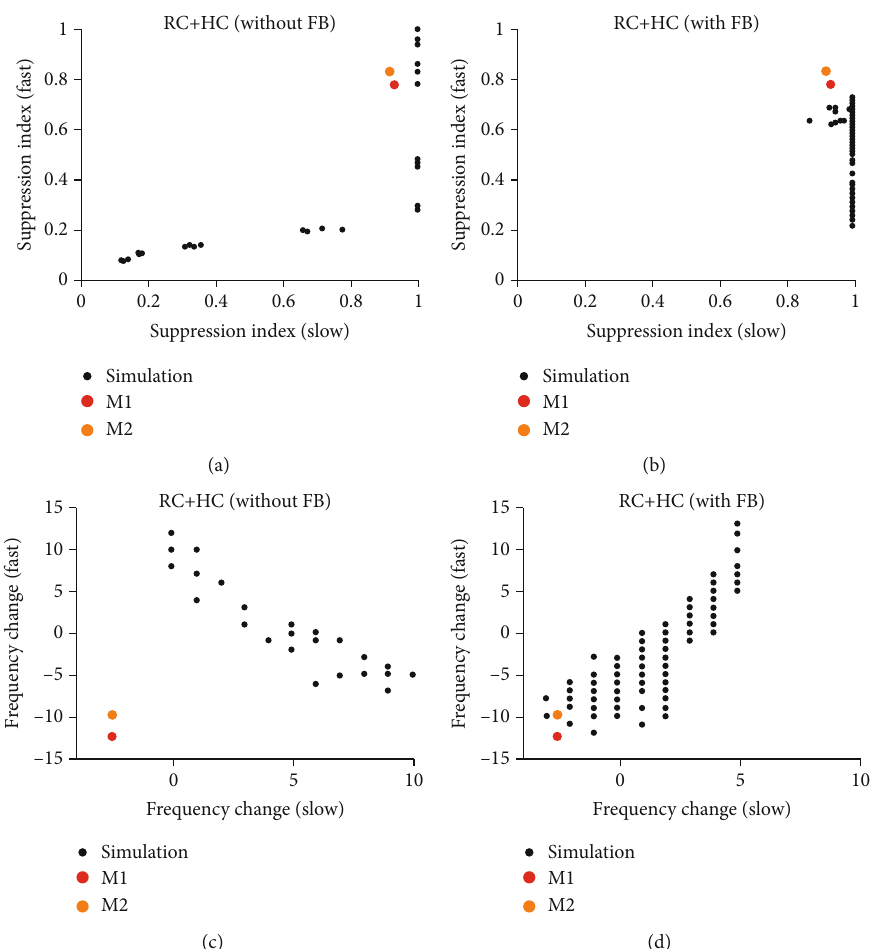
Figure 8: Gamma oscillations in V1 require both HC and FB. (a) shows the scatter plot of suppression index for slow ( x -axis) and fast gamma ( y -axis) in the network without FB. (b) shows the scatter plot of suppression index for slow ( x -axis) and fast gamma ( y -axis) in the network with FB. (c) shows the scatter plot of frequency change for slow ( x -axis) and fast gamma ( y -axis) in the network without FB. (d) shows the scatter plot of frequency change for slow ( x -axis) and fast gamma ( y -axis) in the network with